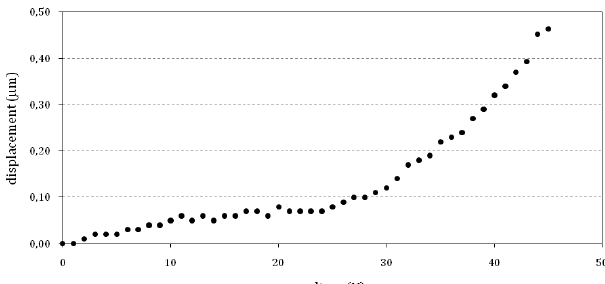
Figure 4: Vertical displacement of the specimen loaded tip measured using the optical interferometric technique with respect to static input voltage (design 1). Measures are affected by an error introduced by surface roughness, particularly at small displacements.